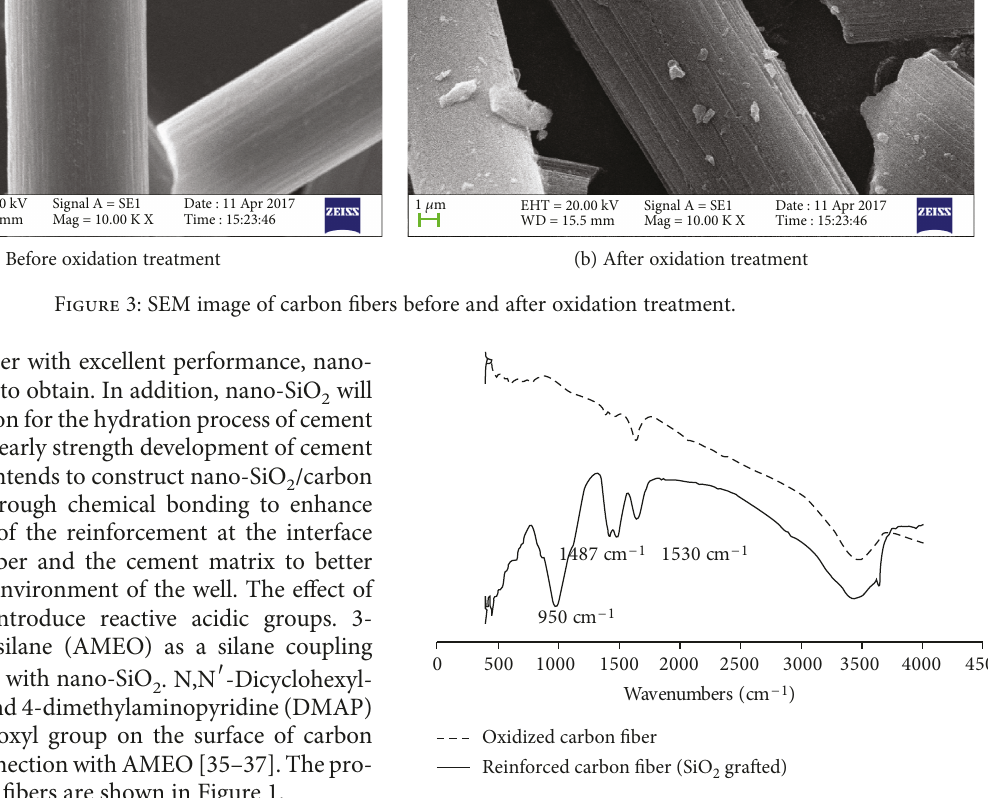
Figure 4: Infrared spectrum of the reinforcement and unreinforced carbon fi